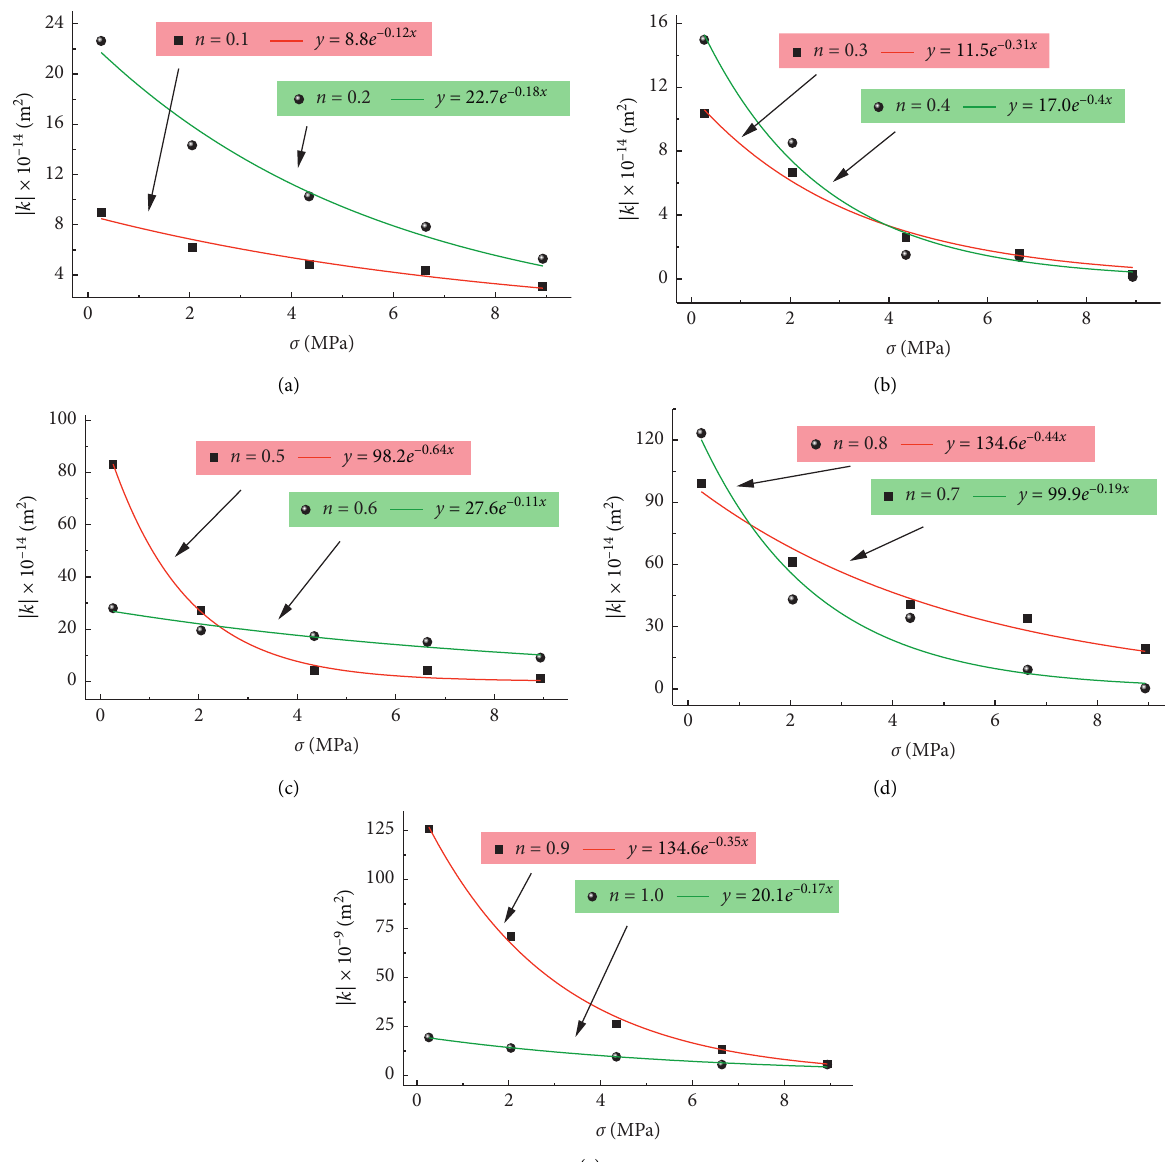
Figure 6: Relationship between effective stress and permeability of samples. (a) n � 0.1; n � 0.2. (b) n � 0.3; n � 0.4. (c) n � 0.5; n � 0.6. (d). n � 0.7; n � 0.8. (e) n � 0.9; n �